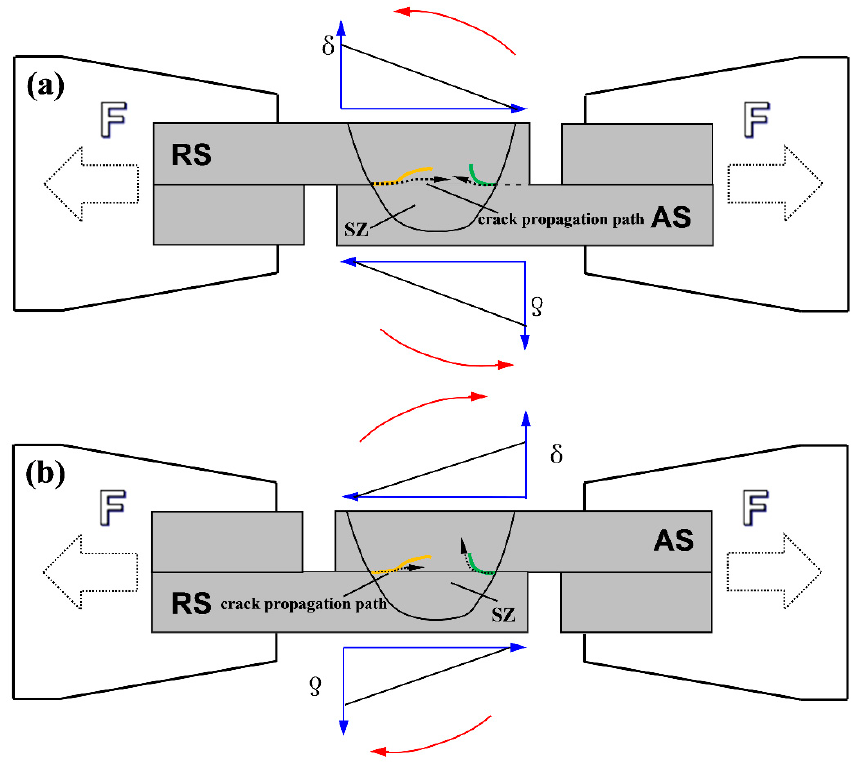
Figure 16. Schematic views of tensile fracture behaviour of lap joints in configuration ( a ) A and ( b ) B.